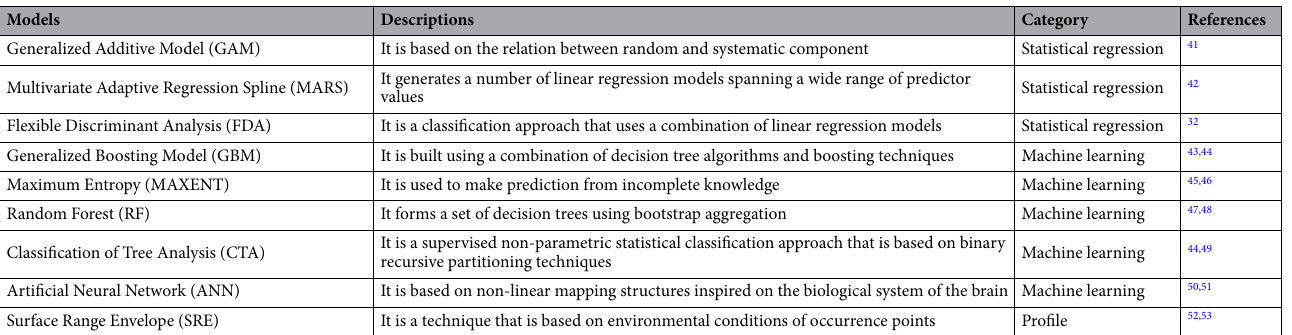
Table 1. Overview of the algorithms of BIOMOD modelling technique used for determining the habitat